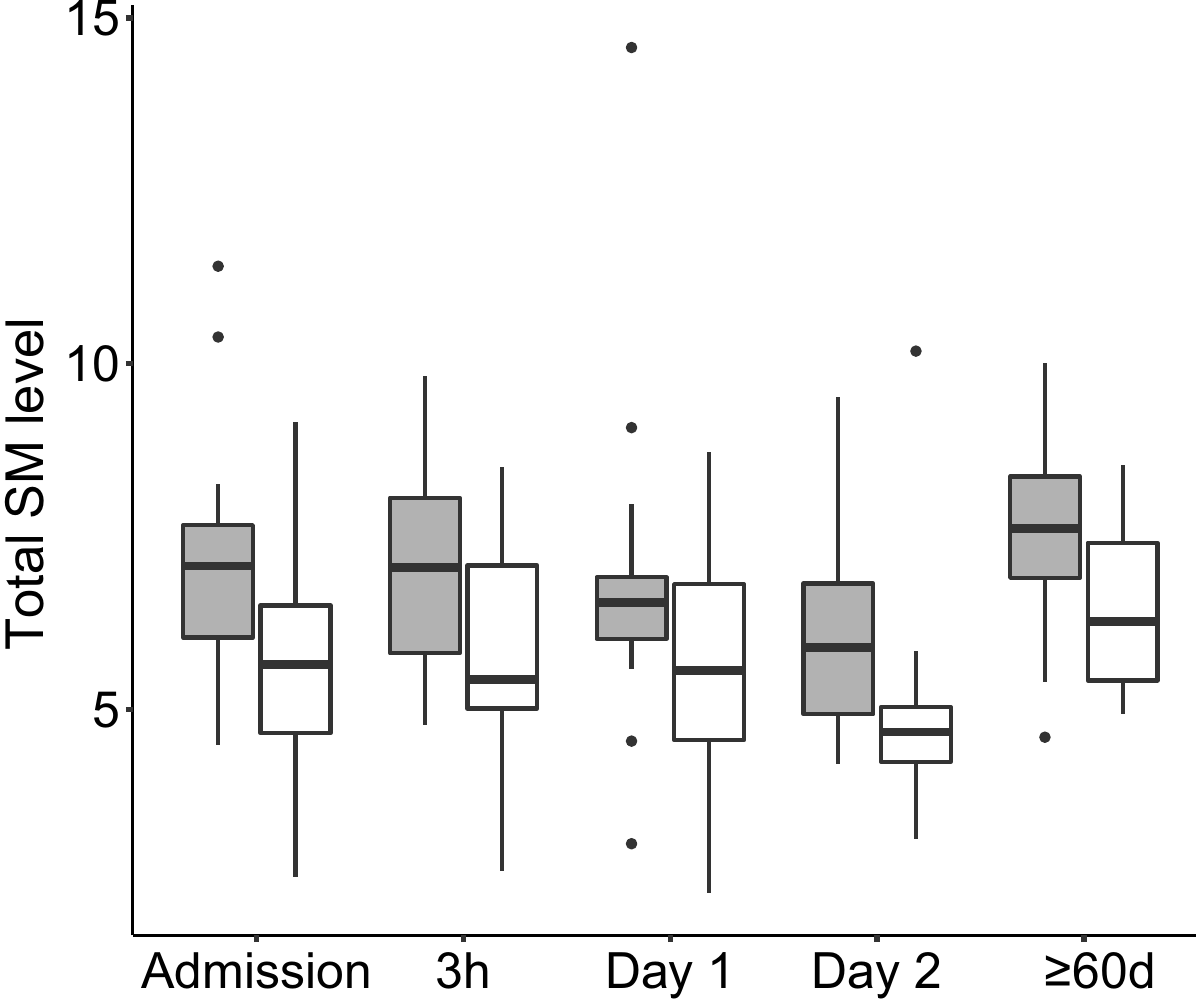
Fig 7. Boxplot diagram showing the distribution of total SM levels at the different sampling time points from admission to full recovery after � 60d. Females are shown in gray boxes and males in white boxes. The SM levels are relative to a known concentration of the IS LPC 19:0. Outliers are shown as dots. Abbreviations: SM,